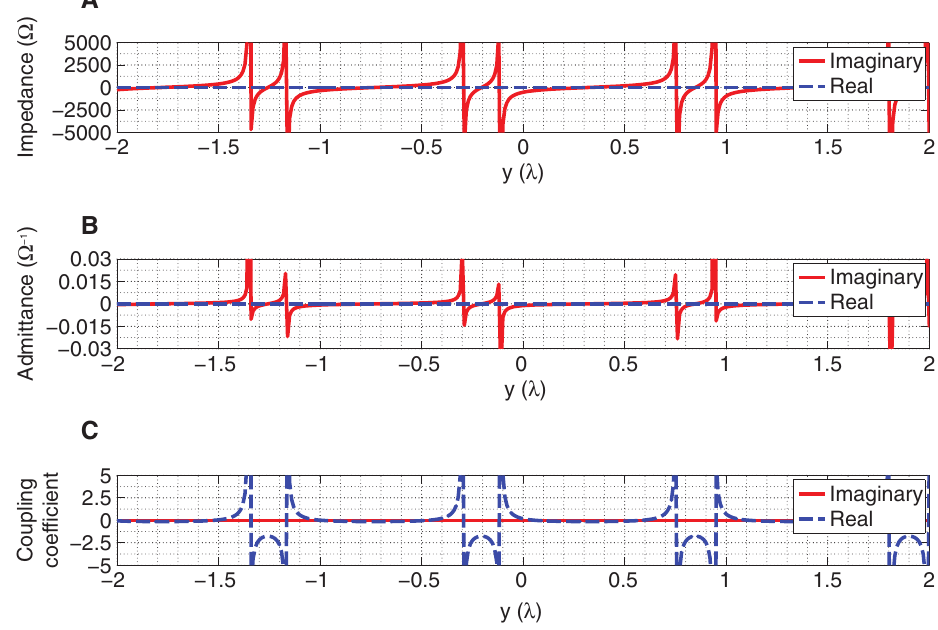
Figure 7: Bianisotropic boundary conditions for 0 ° to 71.8 ° TE refraction at 20 GHz. (A) Imaginary and real components of Z